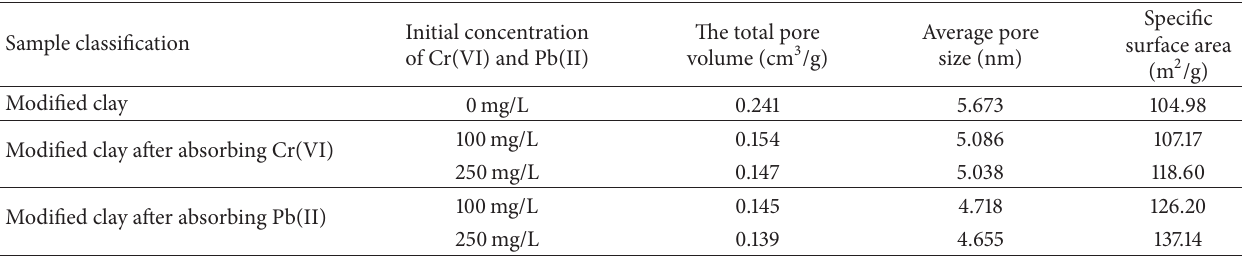
Table 6: Pore parameter of the samples.